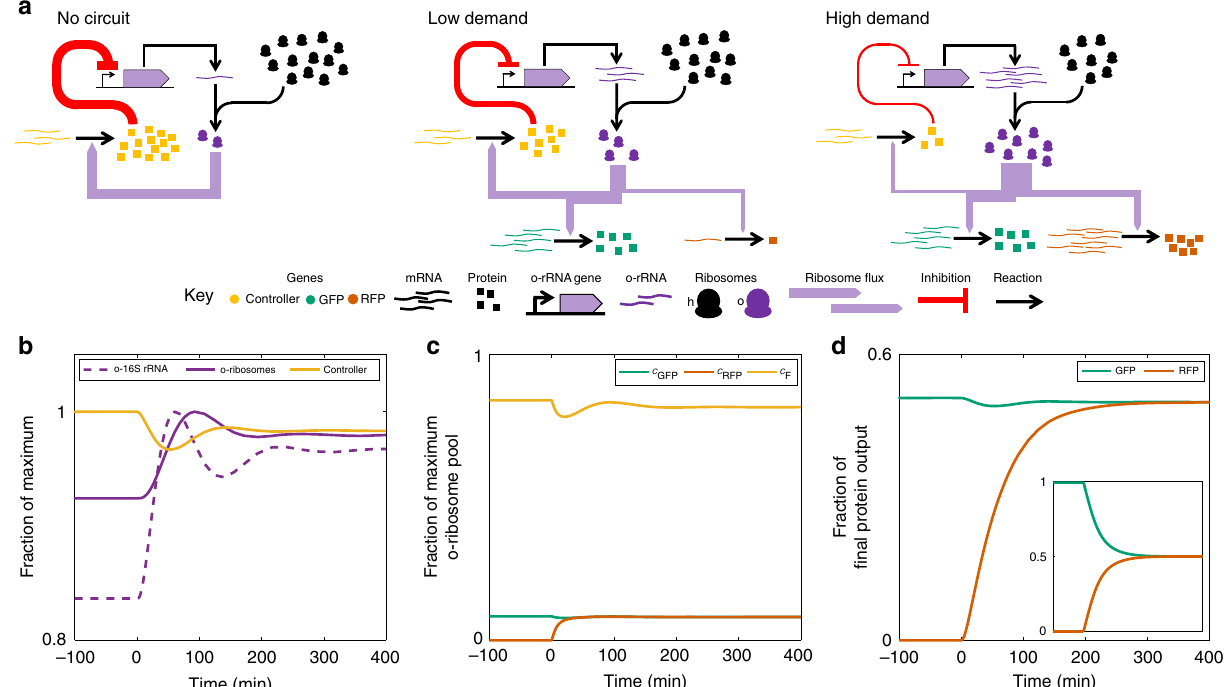
Fig. 5 Operation of the negative feedback controller. a Structure and function of the negative feedback controller. In the absence of the circuit genes, repression of o-rRNA production is high, and so co-option of ribosomes to the orthogonal pool is low. Upon the introduction of a low demand circuit the o- ribosome pool is redistributed to express both circuit and controller genes. This reduces translation of the constitutively expressed controller due to resource competition, and as a result o-rRNA transcription increases. As circuit demand increases (here RFP transcription increases), increased resource competition results in a greater fall in controller translation. This reduces the repression of the o-rRNA production, allowing more co-option of ribosomes from the host ribosome pool. b Simulation showing the changing concentrations of the controller components in response to induction of RFP, which creates increased ribosomal demand. Note the narrow y -axis range. c Changing distribution of the translation complexes, c , in response to RFP induction of genes utilising o-ribosomes for translation. c F , controller mRNA-o-ribosome translation complex. d Protein output over time. Inset, coupling in the o- ribosome pool without controller. The induction rate of the o-rRNA was tuned so that both models produce the same protein